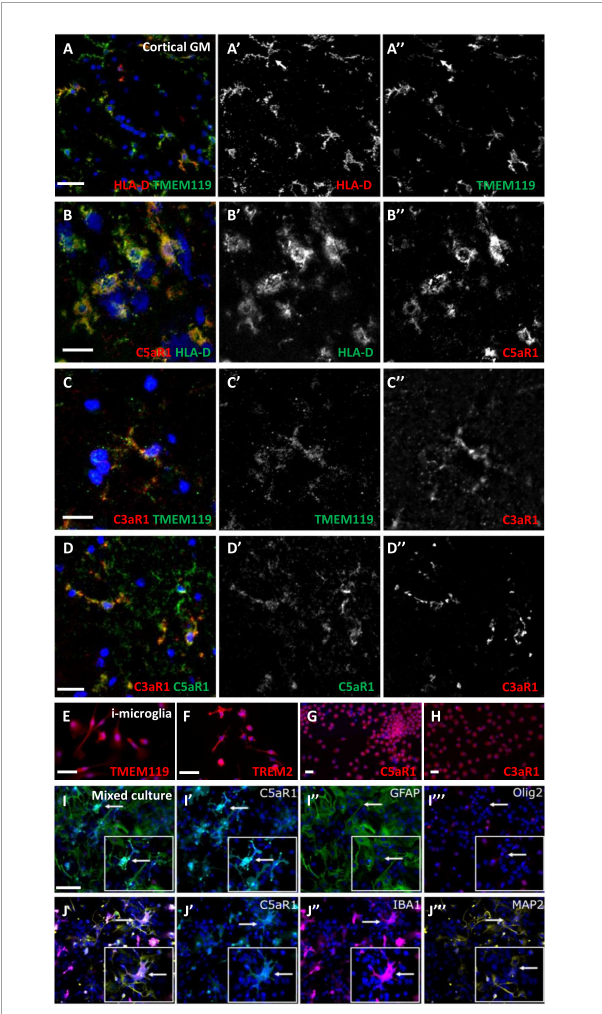
FIGURE4 Microglia/macrophages express complement anaphylatoxin C3a and C5a receptors. C5aR1 microglia/macrophages were seen in the cortical GM in association with TMEM119 (A–A”) and HLA-D (B–B”) , and an example of C3aR1 + /TMEM119 + (C–C”) . Dual C3a/C5aR1 immunostaining showing co-positive C3aR1/C5aR1 cells (D–D”) . Human monocyte-derived microglia-like cells (i-microglia) were cultured for 10 days in vitro and expressed TMEM119 (E) , TREM2 (F), and C3aR1 and C5aR1 (G,H) . Multiplex immunocytochemistry of primary cultures from neonatal mouse brains revealed C5aR1 expression was associated with IBA-1 + microglia but not astrocytes, oligodendrocyte precursor cells (GFAP+, Olig2+, respectively, I–J” ) or neurons (MAP2 + ; J”’ , arrows represent cells shown in inserts) in day 5 cultures. Scale bars = 20 µ